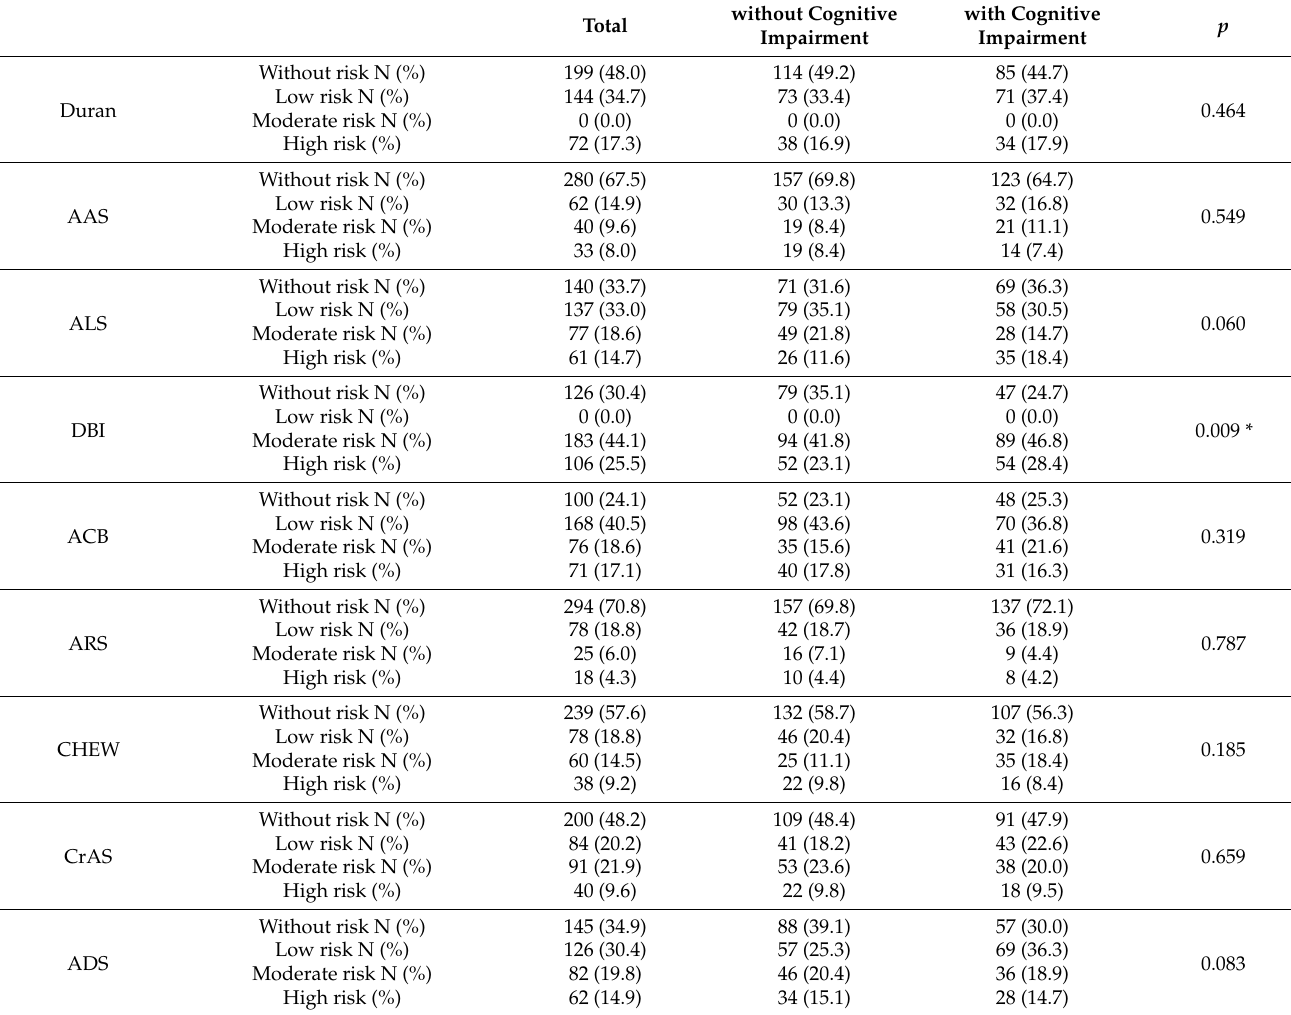
Table A7. Anticholinergic risk by all the scales in total patients, with and without cognitive